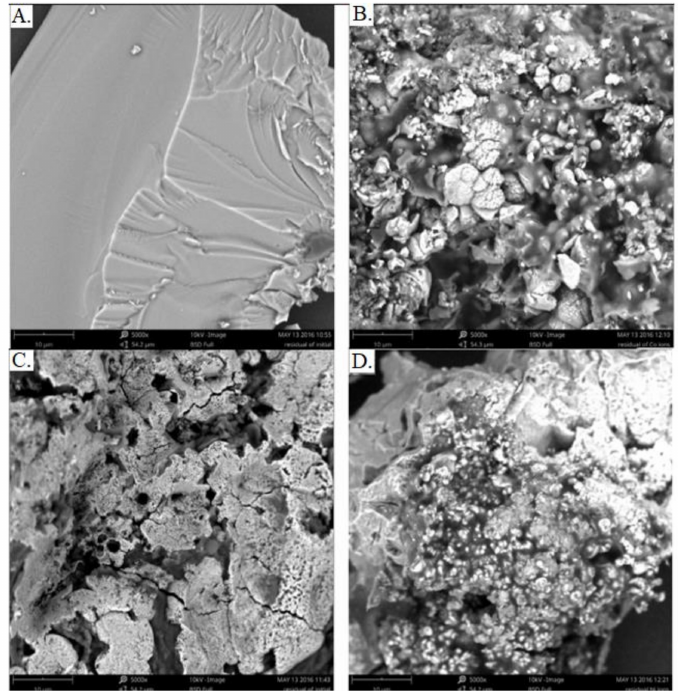
Figure 5. SEM images of the samples: A —CM; B —Co-CMC; C —Fe-CMC, and D —Ni-CMC. X-ray diffraction (XRD) measurements were taken for interpretation of phase and structure composition of the obtained CMC (Figure